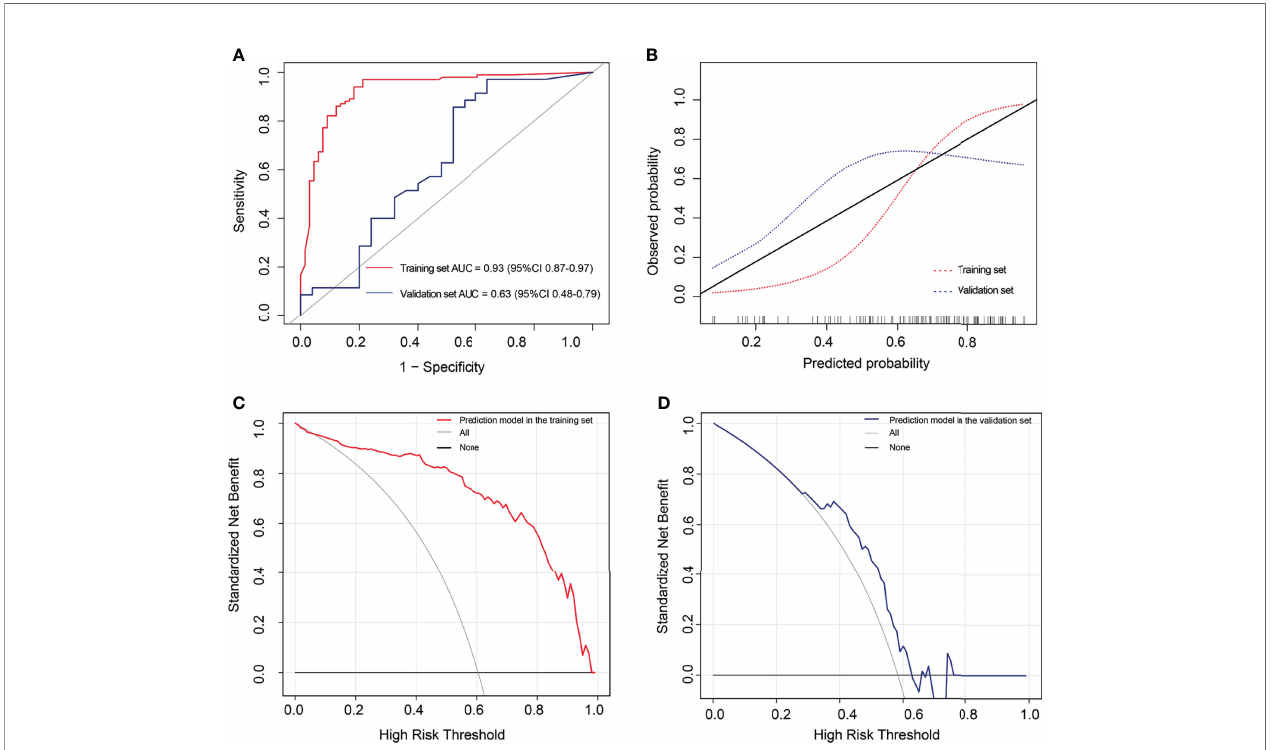
FIGURE 7 | The performance of the extreme gradient boosting (XGBoost) classi fi er. (A) Receiver operating characteristic curves of the XGBoost classi fi er. (B) Calibration curves of the XGBoost classi fi er. (C, D) Decision curve analysis for the XGBoost classi fi er. The red line represents the training set. The blue line represents the validation set. The gray line represents the hypothesis that all patients had high tumor – stroma ratio (TSR). The black line represents the hypothesis that all patients had low TSR. (C) The decision curves in the validation set show that the radiomics score offered greater bene fi t than the treat-all-patients as low TSR scheme or the treat-none as high TSR scheme in the training set with a threshold probability >0.06. (D) The prediction model offered greater bene fi t than the treat-all- patients as high TSR expression scheme or the treat-none as low TSR expression scheme in the validation set with a threshold probability between 0.29 and